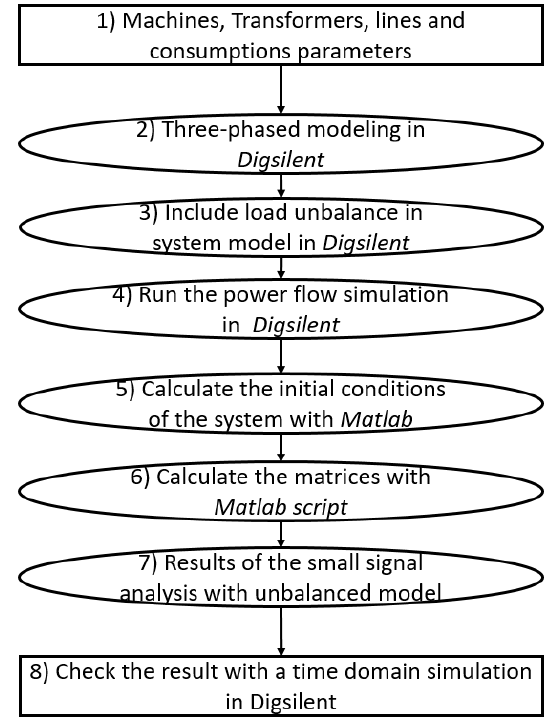
Figure 5. Diagram of the methodology flow used in the case simulation.